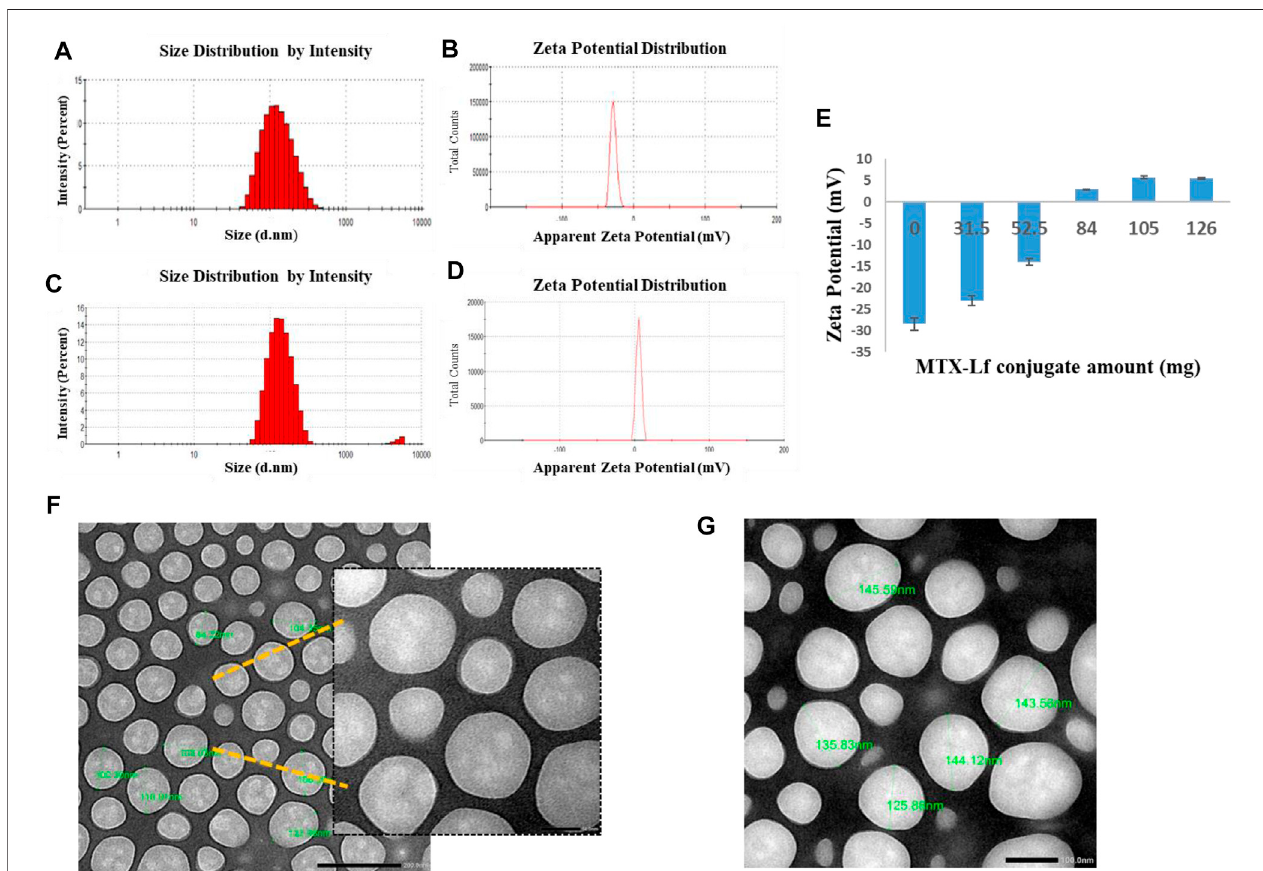
FIGURE 3 | (A) Size distribution of EXE\LCNPs F2 , (B) zeta potential of EXE\LCNPs F2 , (C) size distribution of MTX/Lf\EXE\LCNPs F4 , (D) zeta potential of MTX/ Lf\EXE\LCNPs F4 , (E) effect of addition of MTX – Lf conjugate F3 amounts on the zeta potential of EXE\LCNPs F2 , (F) TEM of EXE\LCNPs F2 , and (G) TEM of MTX/ Lf\EXE\LCNPs F4